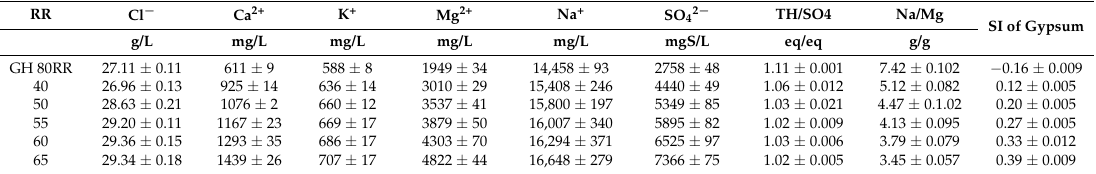
Table 2. Average ( n = 3) results from passing the retentate of the dense UF step (GH membrane, 80% RR) through a nanofiltration membrane (DLF1021) at P = 15 bar and 20 ± 2 ◦ C. AS used: Genesys